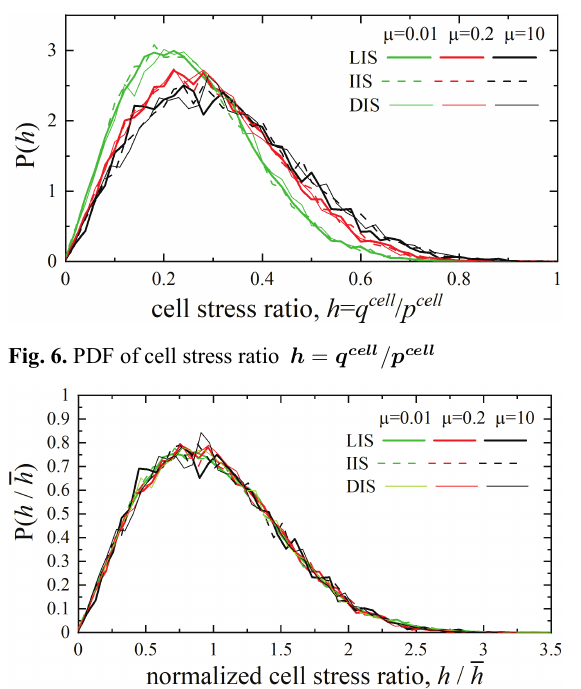
Fig. 7. PDFs of cell stress ratio normalised by the mean